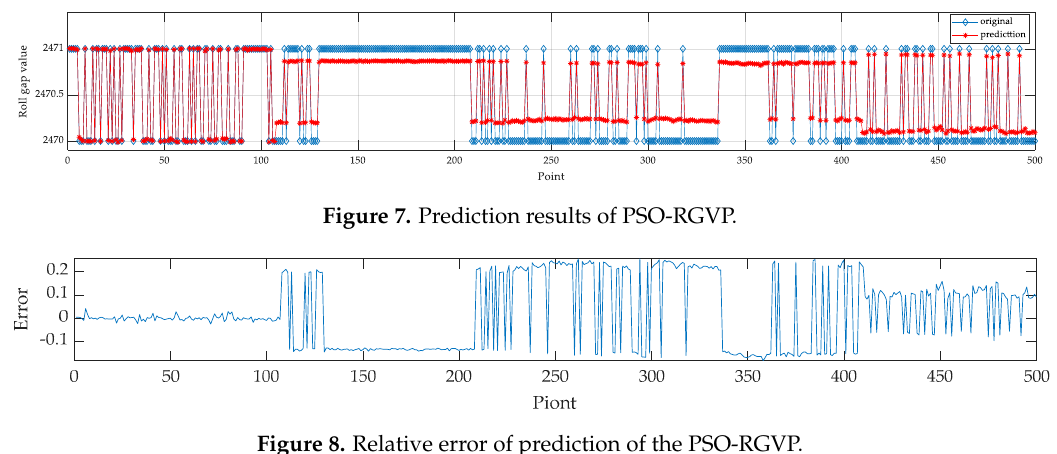
Figure 6. Parameter optimization results of PSO.